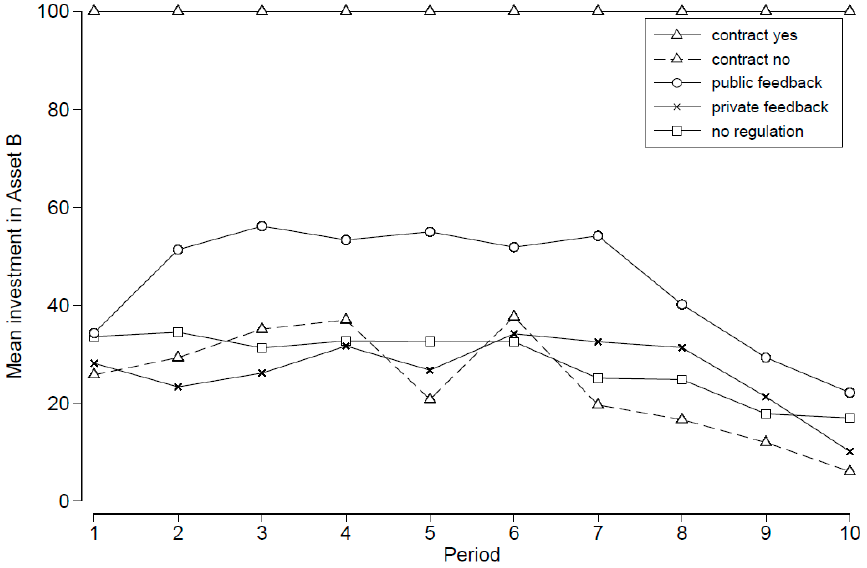
Figure 4. Mean investment in Asset B over time.